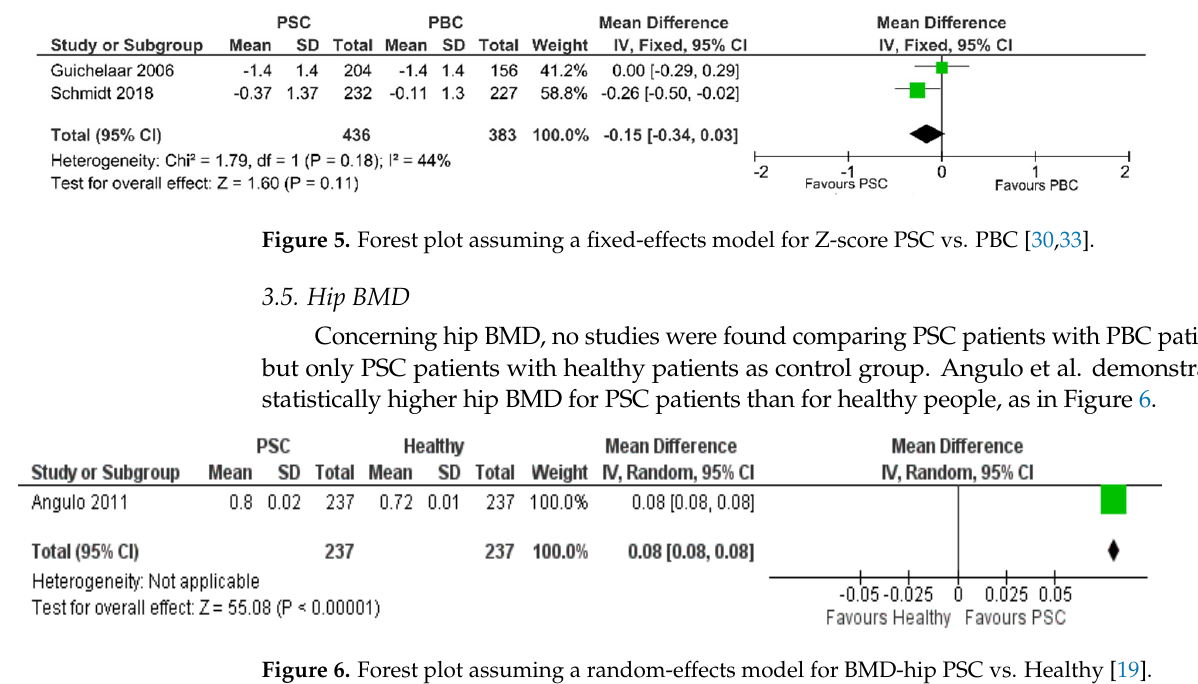
Figure 6. Forest plot assuming a random-effects model for BMD-hip PSC vs. Healthy [19].